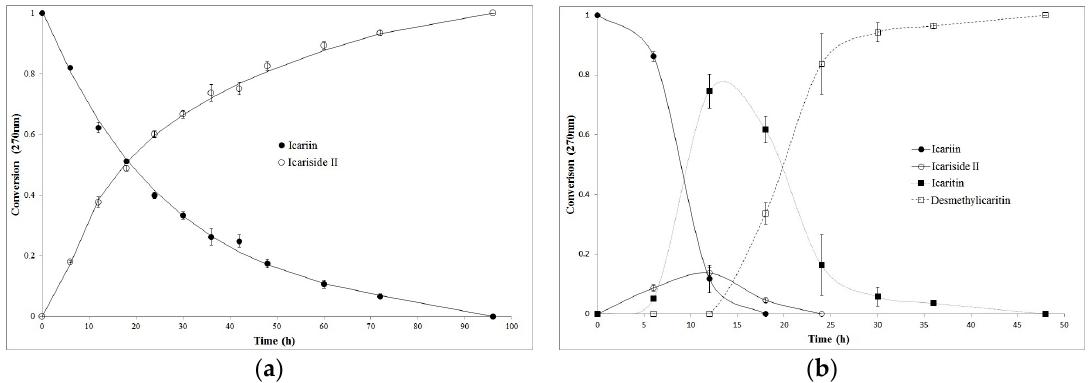
Figure 5. Time-dependent biotransformation of icariin by ( a ) Streptococcus sp. MRG-ICA-B and ( b ) Blautia sp. MRG-PMF-1.